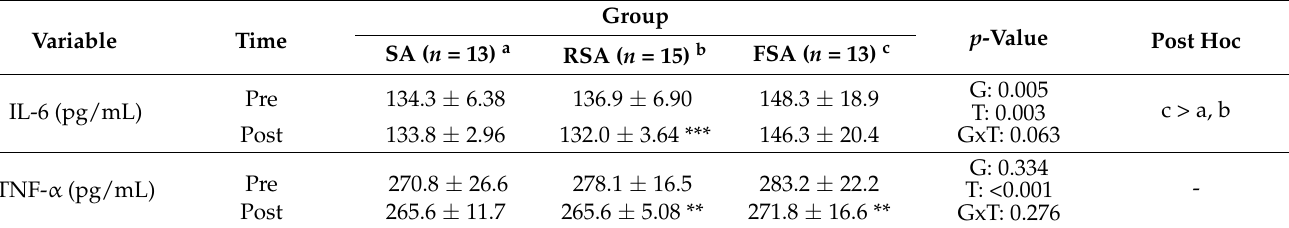
Table 5. Measurements of inflammation by group and